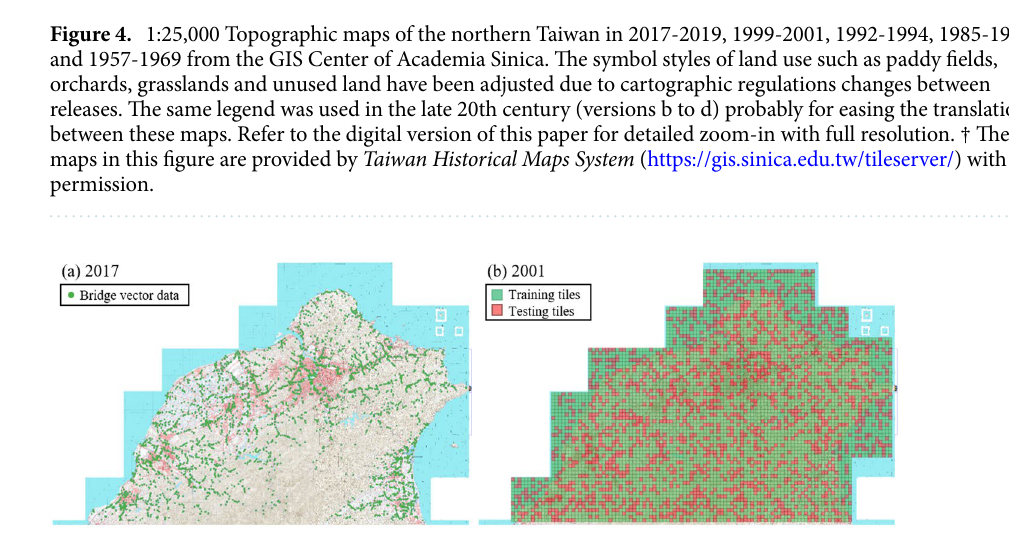
Figure 5. ( a ) Bridge vector data on the 2017 contemporary map of northern Taiwan. Green dots show the 3, 542 annotated bridges from the vector data. ( b ) Train/test split of the 5,986 map tiles at zoom-level 15.Green squares depicts the training tiles and red squares depicts testing tiles. † The maps in this figure are provided by Taiwan Historical Maps System (https:// gis. sinica. edu. tw/ tiles erver/) with